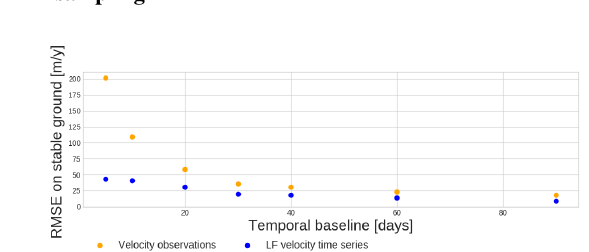
Figure 7. Comparison of RMSE over stable areas for different temporal samplings. RMSE is performed over ice-free areas according to the Randolph Glacier Inventory V6.0.